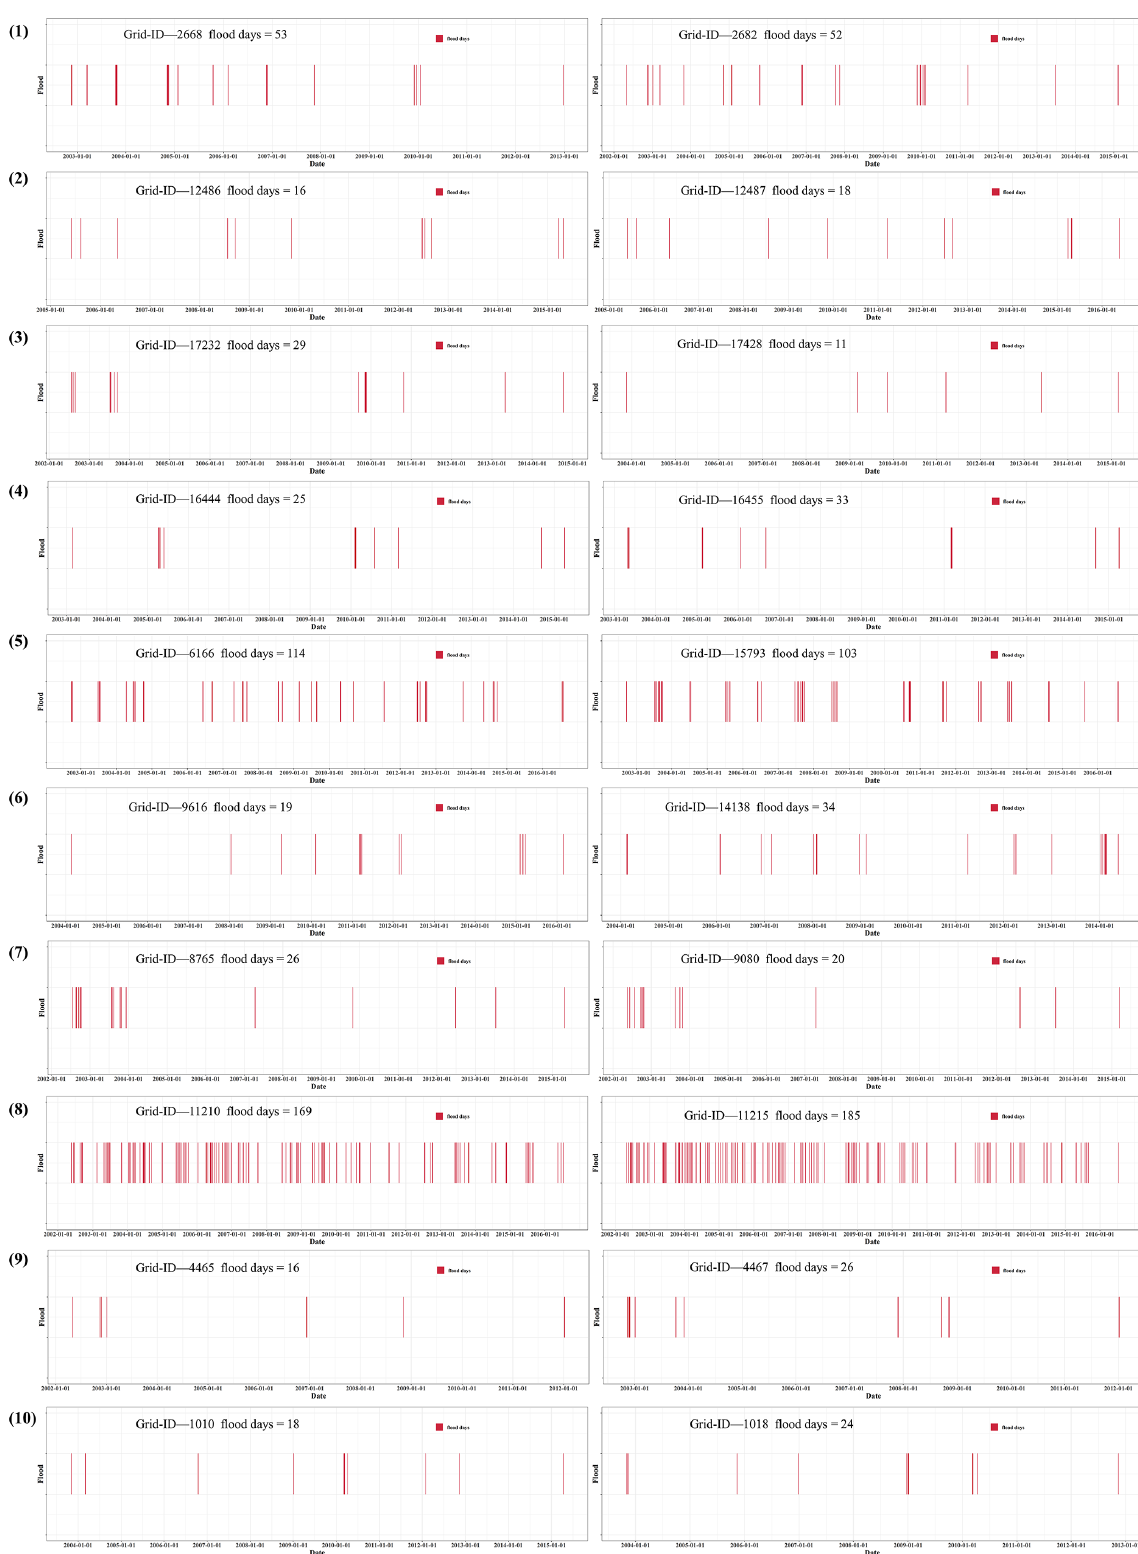
Figure 7. Flood detection results for different glacial regions (specific regions are consistent with Fig. 6).